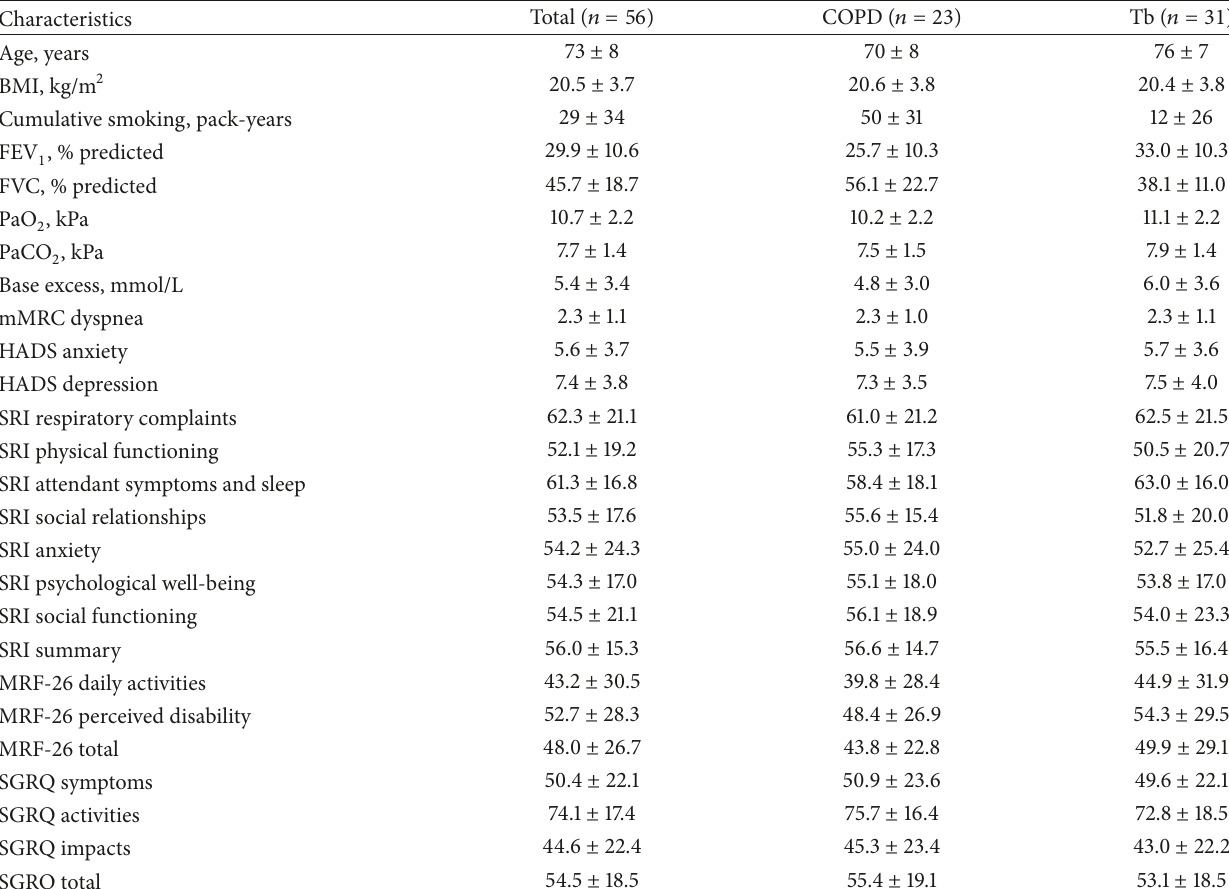
Table 1: Baseline characteristics of 56 patients using noninvasive